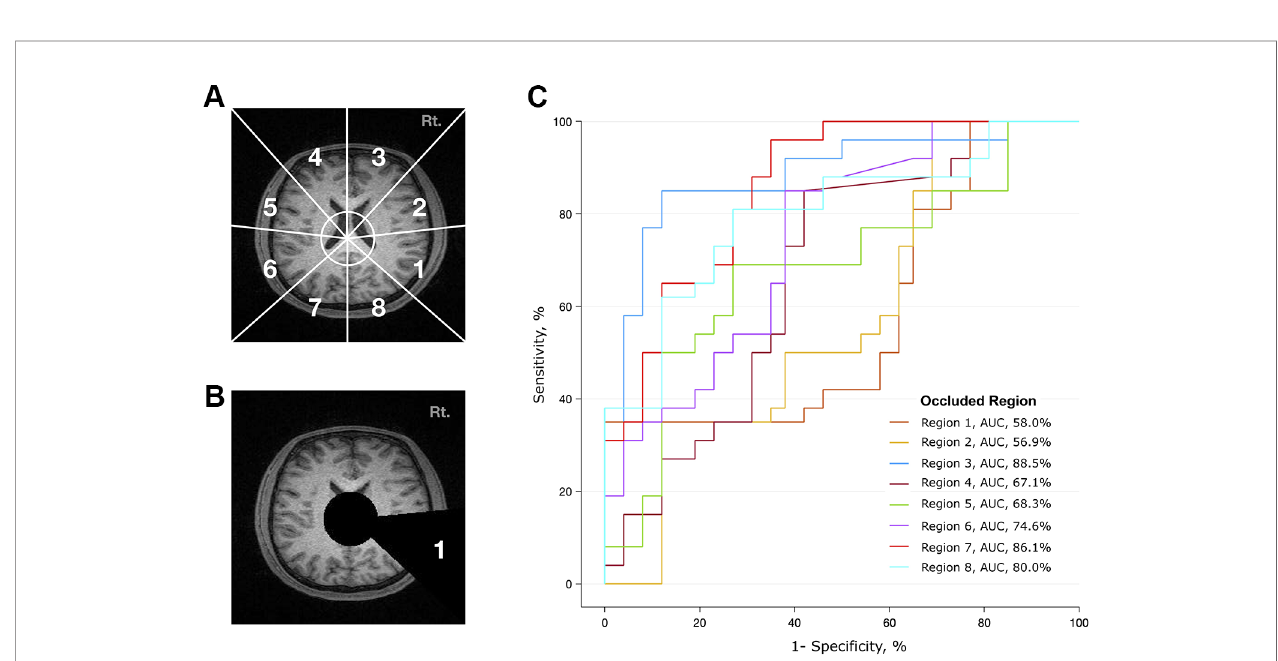
FIGURE 3 | Analysis of contributing brain regions for detecting schizophrenia. Contribution of each brain region in identifying MR images from patients with schizophrenia. Each MR transverse slice was divided into eight regions, and one of these regions was occluded with a black triangle. Thus, no information was provided from this portion of the brain. The deep learning algorithm was trained with these handicapped inputs and subsequently used to classify MR images. (A) Schematic diagram of eight arbitrarily determined brain regions. The center of the circle corresponds to the center of the midbrain, and the endpoint of each line corresponds to a vertex and midpoint of the image. (B) A sample slice that was used as an input to the algorithm. Areas corresponding to ventricles and region 1 are covered. (C) Performance of the deep learning algorithm. Region 1 mostly contributed to identifying schizophrenia, as the performance dropped to an AUC of 0.58 when the information from region 1 was not